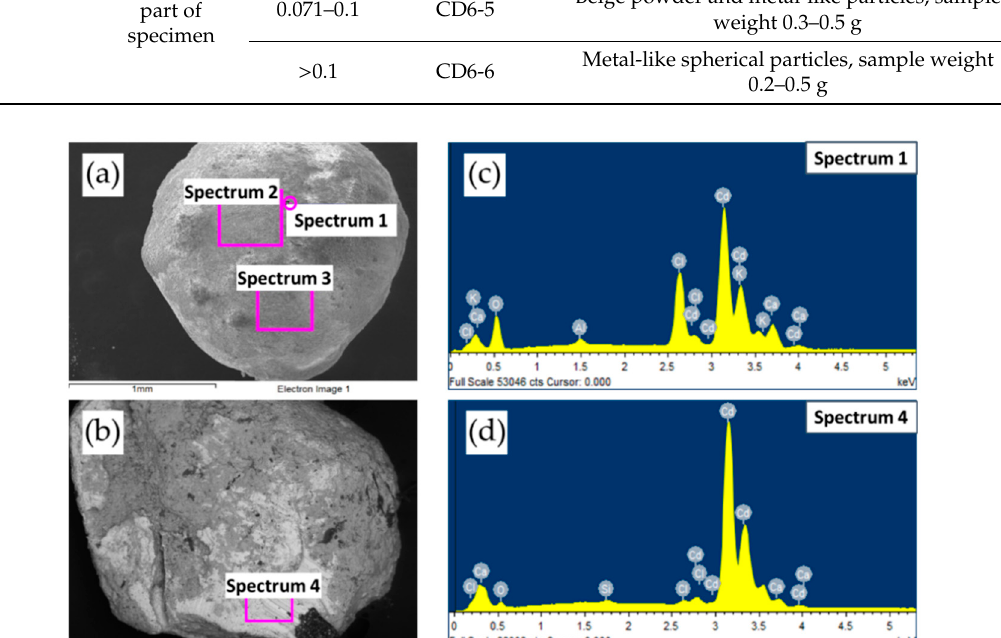
Figure 5. Optical images of the CD6-2 ( a ), CD6-5 ( b ) and CD6-6 ( c ) fractions at magnifications 200×, 150× and 50×, respectively.